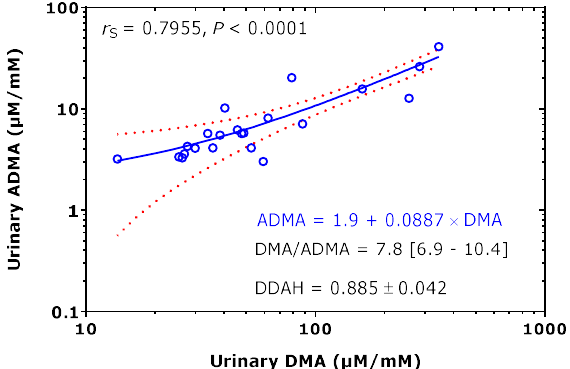
Figure 6. Spearman correlation and linear regression analysis between the creatinine-corrected excretion rates of asymmetric dimethylarginine (ADMA) and dimethylamine (DMA) of the data (22 pairs), taken from Table 1. Note the logarithmic scale on both axes. r S , Spearman coe ffi cient of correlation. Doted curves indicate the 95th confidence interval. Dimethylarginine dimethylaminohydrolase (DDAH) = [DMA] / ([DMA] + [ADMA]), relative whole-body DDAH